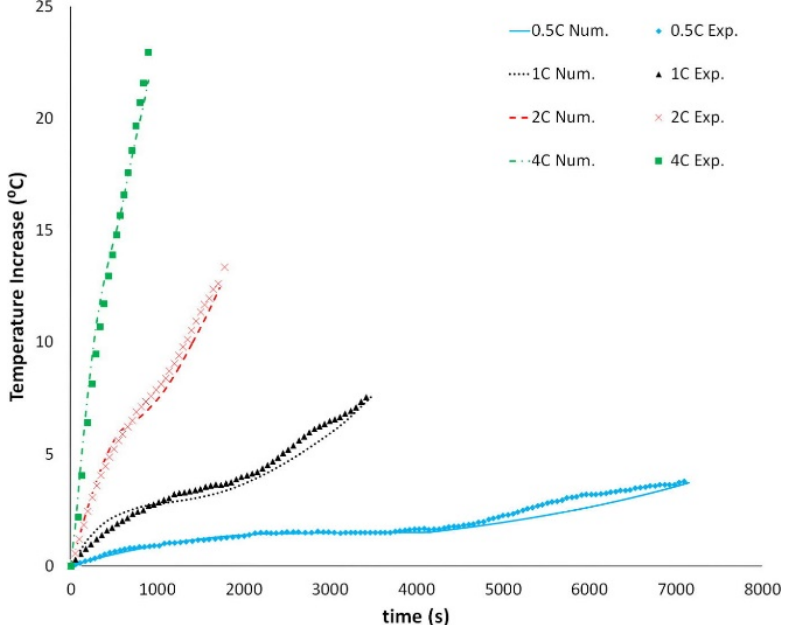
Figure 3. Numerical and experimental validation of average surface temperature during various discharge rates [17].